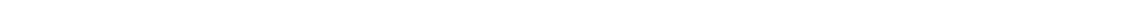
Fig. 3 Increase and variability in centriole length are recurrent in cancer cell lines. a Immuno fl uorescence images of cell lines without (upper panel) and with (lower panel), centriole length deregulation. Cells were stained with DAPI (blue), α -tubulin (red), centrin (green) and CP110 (red-insets) antibodies. Scale bar 5 µ m, insets 1 µ m. b Output of the secondary screening for centriole length in the NCI-60. To validate the primary screening, the top 50% of over- elongation, and a subset of the less-defective ones, were processed in the secondary screening. The results of the secondary screening are depicted in the bar graph (cell lines are ranked according to their percentage of mitotic cells containing at least one overly long centriole). The mean centriole length (blue) and the variance-to-mean ratio (VMR-red), a normalised measure of the dispersion of the distribution, are depicted for each cell line. The cut-off for centriole over-elongation (in green) was set to 5% which corresponds to the average percentage (1%) of cells with centriole over-elongation in the 5 non- cancerous cell lines plus 2 s.d. (2%). 22 cell lines display signi fi cant centriole over-elongation. Centriole length was scored in 3D using centrin staining. From 207 to 388 centrioles were measured per cell line. The magenta asterisks label the cell lines that were selected for analysis by TEM. c TEM images of longitudinal sections of normal-length centrioles (around 500 nm) in the control (RPE-1) and SN12C cell lines, and of overly long centrioles in HOP-62 and MDA-MB-435 cell lines (740 and 1800 nm, respectively). Note the presence of a crack (arrow) in the overly long centriole of MDA-MB-435 cell. Each TEM picture represents an individual cell. Scale bar 500 nm. d Quanti fi cation of centriole length, using the Image J software, from TEM images of longitudinal sections of different centrioles for the control (#22, median = 427 nm, VMR = 2.7), SN12C (#20, median = 486 nm, VMR = 4.5), HOP-62 (#25, median = 502 nm, VMR = 51.9) and MDA-MB-435 (#23, median = 546 nm, VMR = 280.3) cell lines. The bar represents the mean ± s.d. ***represents p < 0.001 and **** p < 0.0001 (Mann – Whitney statistical